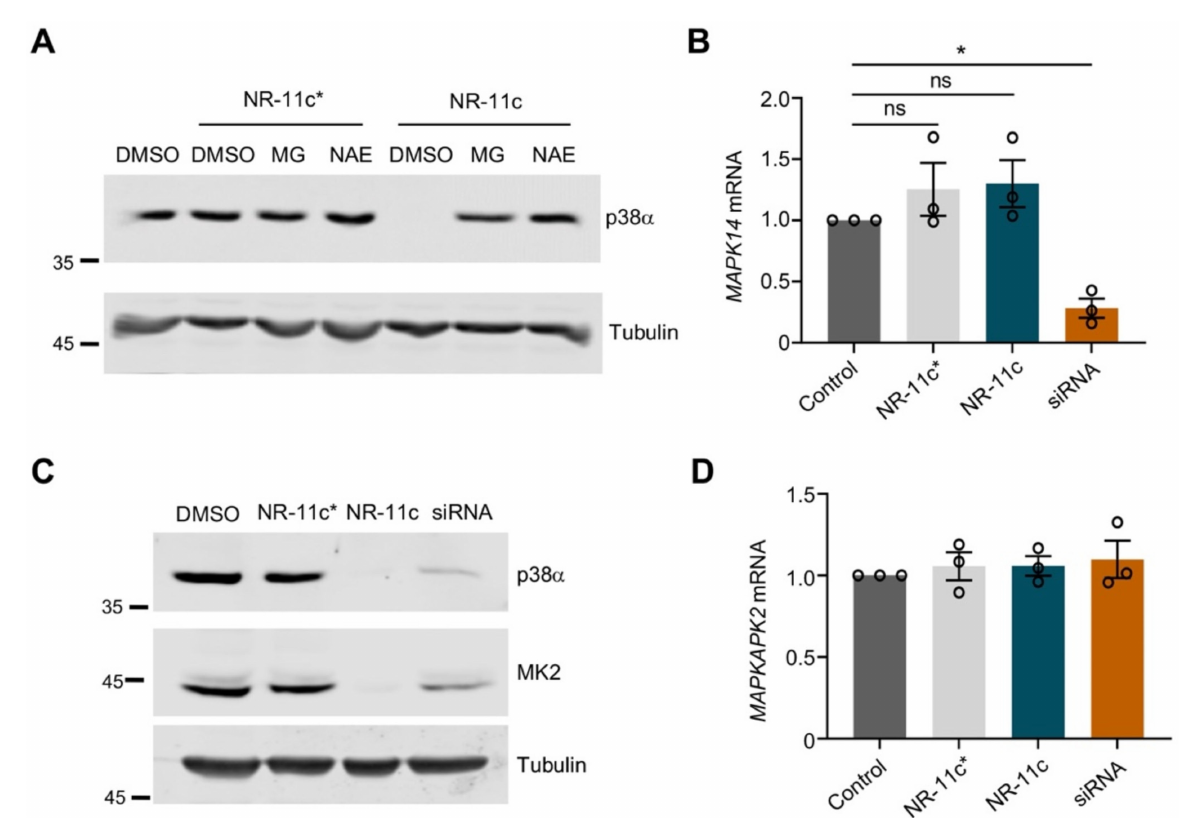
Figure 4. NR-11c induces degradation of p38 α in a proteasome-dependent manner. ( A ) MDA-MB-231 cells were pre-treated with the proteasome inhibitor MG132 (MG) at 20 µ M or the NAE inhibitor at 1 µ M for 1 h prior to incubation with either NR-11c or the inactive compound NR-11c* at 1 µ M for 8 h. Cells were collected, and p38 α levels were analyzed by immunoblotting. ( B ) MDA-MB-231 cells were transfected with siRNA against the p38 α -encoding mRNA MAPK14 and were analyzed 48 h later or treated for 24 h with the indicated compounds at 1 µ M or with DMSO, and then RNA was extracted and was subjected to RT-qPCR using primers specific for MAPK14 . GAPDH was used for normalization. ( C ) MDA-MB-231 cells were transfected with siRNA against p38 α or treated with the indicated compounds and analyzed after 48 or 24 h, respectively. Cell lysates were analyzed by immunoblotting using the indicated antibodies. ( D ) MDA-MB-231 cells were treated as in ( B ), and the purified RNA was subjected to RT-qPCR using primers specific for MAPKAPK2 (MK2) or for GAPDH for normalization. Immunoblotting experiments were performed with a minimum of n = 2 biological replicates and similar results were obtained each time. Statistical analyses were performed using ANOVA and GraphPad Prism Software 9.4.1. * p < 0.05; ns, not significant. The uncropped blots are shown in Supplementary Materials File